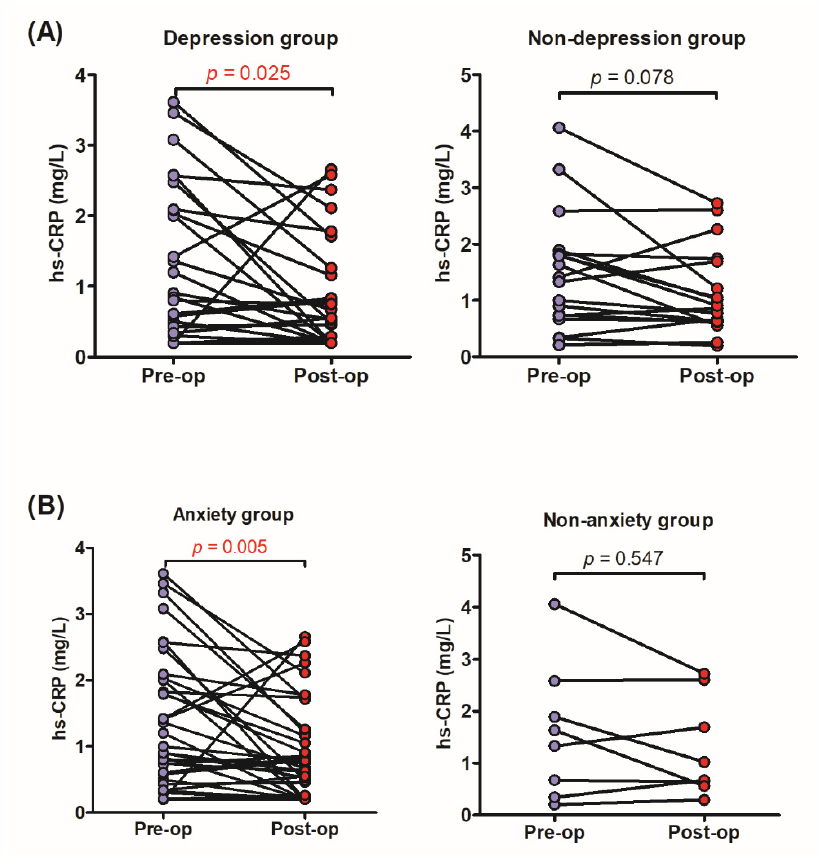
Figure 2. The change of serum hs-CRP level in preoperative ( A ) depression group (left panel), non-depression group (right panel), ( B ) anxiety group (left panel), and non-anxiety group (right panel). The postoperative serum hs-CRP significantly decreased in the depression and anxiety groups but not in the non-depression and non-anxiety groups. hs-CRP: high-sensitivity C-reactive protein; pre-op: preoperative; post-op: postoperative.